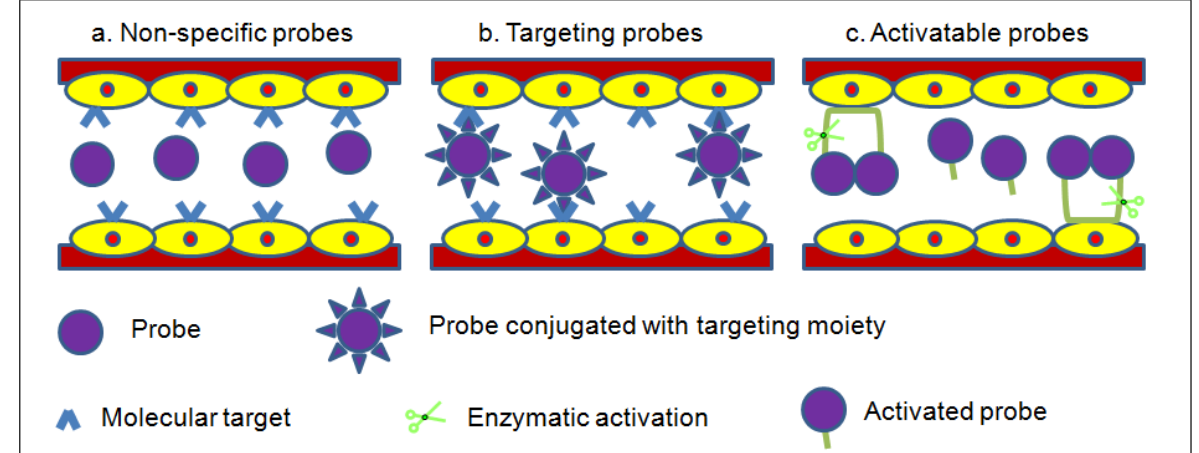
Figure 3. Modes of contrast generation of fluorescent probes. ( a ) Non-specific compartmental distribution of the probes. ( b ) Targeted binding of probes via surface ligands to molecular targets. ( c ) Activatable probes quenched in their native state and become fluorescent by enzyme-mediated